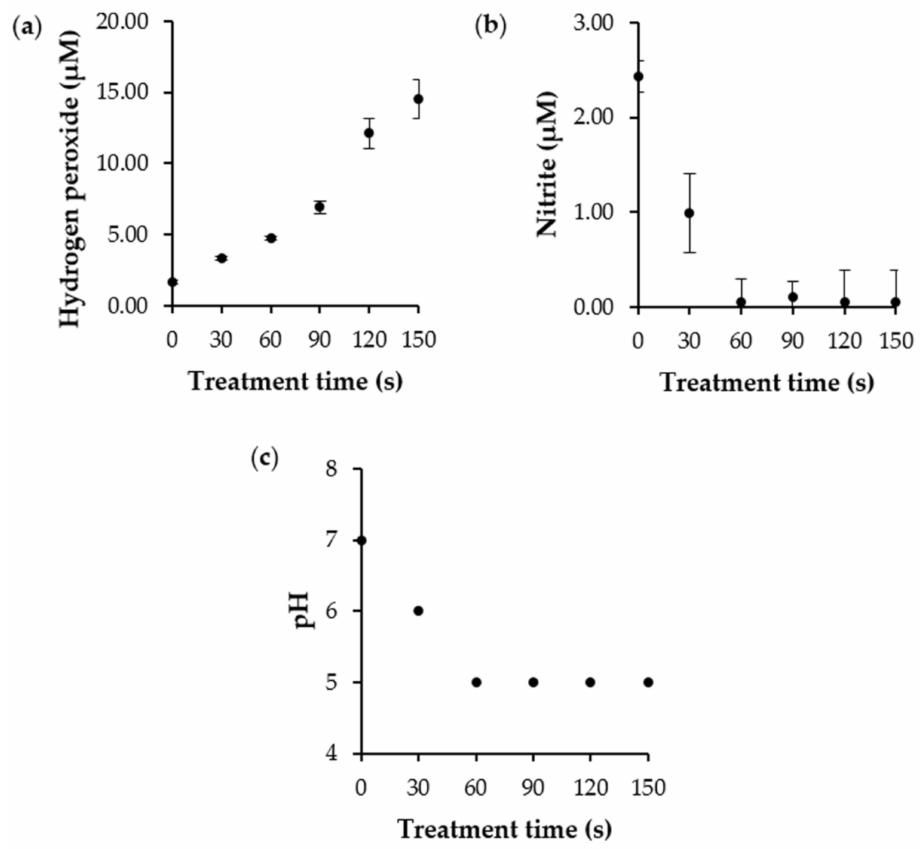
Figure 4. ( a ) The hydrogen peroxide, ( b ) nitrite concentration, and ( c ) pH after ARTP treatment. The experiments were performed in triplicate, and the results were expressed as mean ± SD ( n =